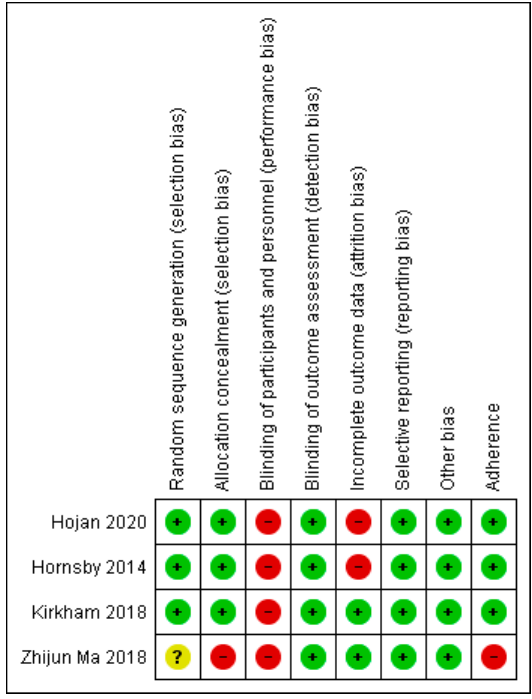
Figure 2. Summary of the judgements for the risk of bias of each study.